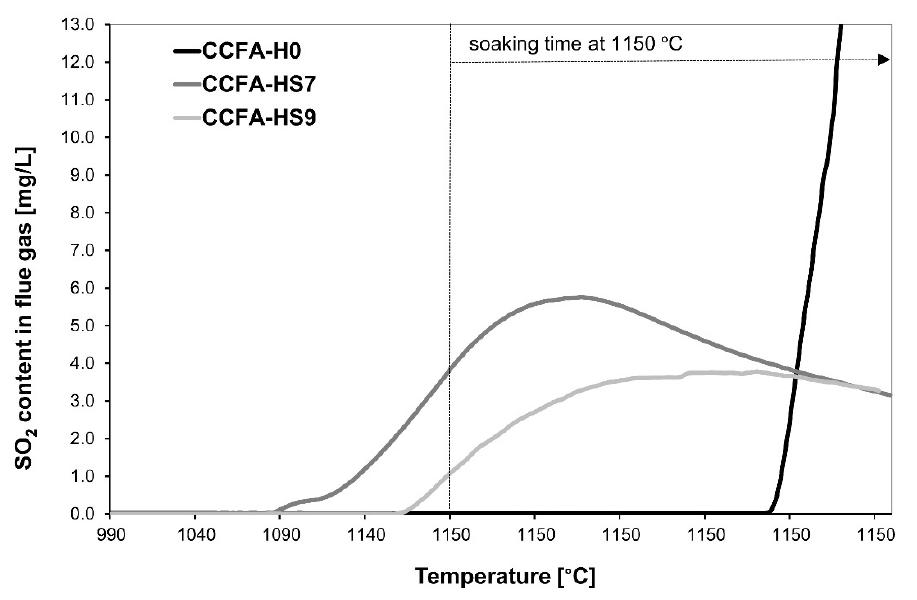
Figure 6. The sulfur dioxide content in the flue gas during the firing process is dependent on the addition of sodium carbonate.